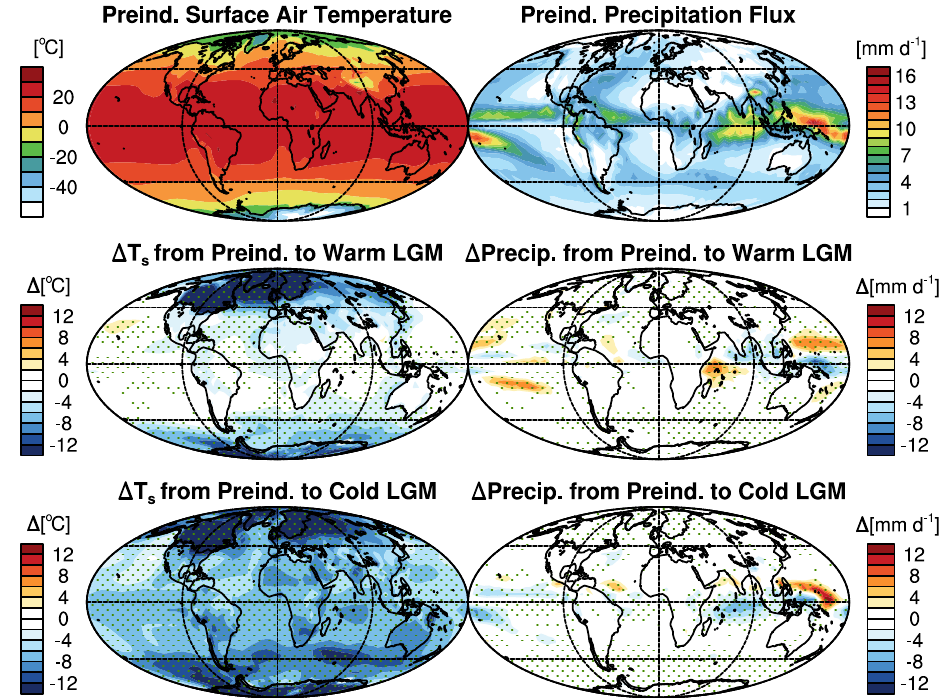
Fig. 3. Simulated surface air temperatures (left column, ◦ C) and precipitation fluxes (right column, mmd − 1 ). Top panels: preindustrial conditions. Bottom panels, absolute change from preindustrial to warm-LGM (middle row; CLIMAP, 1976) and cold-LGM (bottom row; Webb et al., 1997) scenarios. Both difference plots share a common color bar for each variable. The green dots indicate regions with significant changes, as determined by a Student’s t test with degrees of freedom adjusted for autocorrelation (Wilks, 2011). The changes relative to the preindustrial in present-day surface temperatures and precipitation fluxes are small, and significant only at the poles and over small areas of the tropics, respectively (not shown). Table 4. Climate results for the four